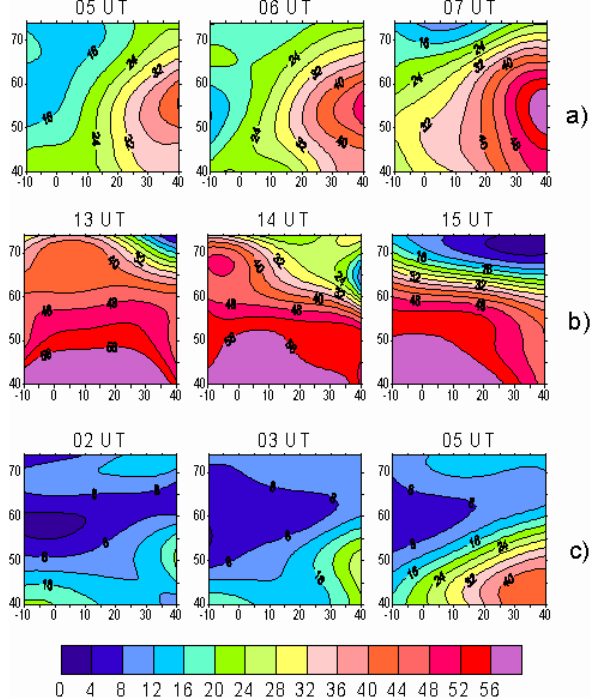
Fig. 4. Observed TEC during the expansion phases of three sub- storms: ( a ) Number 1 of 28 April, ( b ) Number 2 of 28 April, and ( c ) Number 3 of 29 April. Numbers on the scale are TEC in units of 10 16 m − 2 .